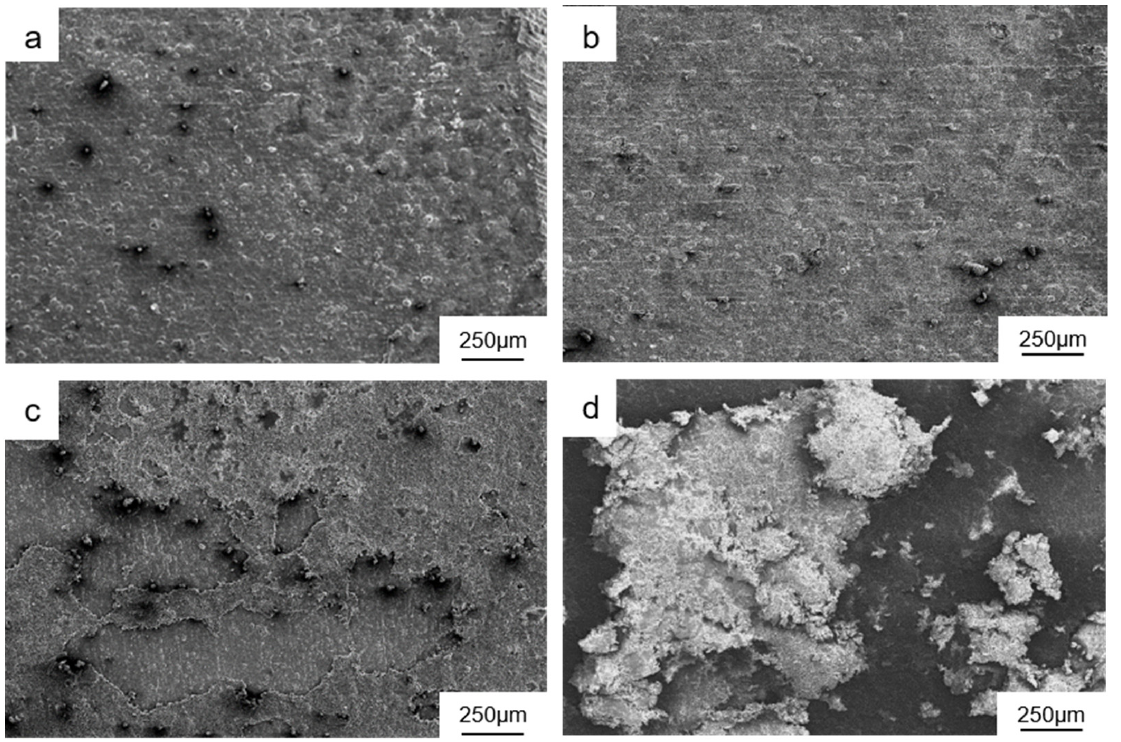
Figure 7. Surface morphology of Al-2Li alloy after 5 h oxidation: ( a ) 400 °C, ( b ) 450 °C, ( c ) 500 °C, ( d ) 550 °C. The microstructure of the Al − 2Li − Sc alloy after adding 0.2 wt% Sc is shown in Figure 8. After high-temperature oxidation (400 ◦ C, 450 ◦ C, 500 ◦ C, and 550 ◦ C), the surface of the oxide film was improved. After oxidation at 400 ◦ C for 5 h, the surface was relatively complete. After oxidation at 450 ◦ C for 5 h, the planarity of the oxide film was improved. As the oxidation temperature continued to rise, the convex oxidation cell formed at 500 ◦ C had holes. After oxidation at 550 ◦ C for 5 h, the protrusions on the surface were large, showing “tumor” shaped distribution, and the formed “tumor” shaped oxides were large, and there were many